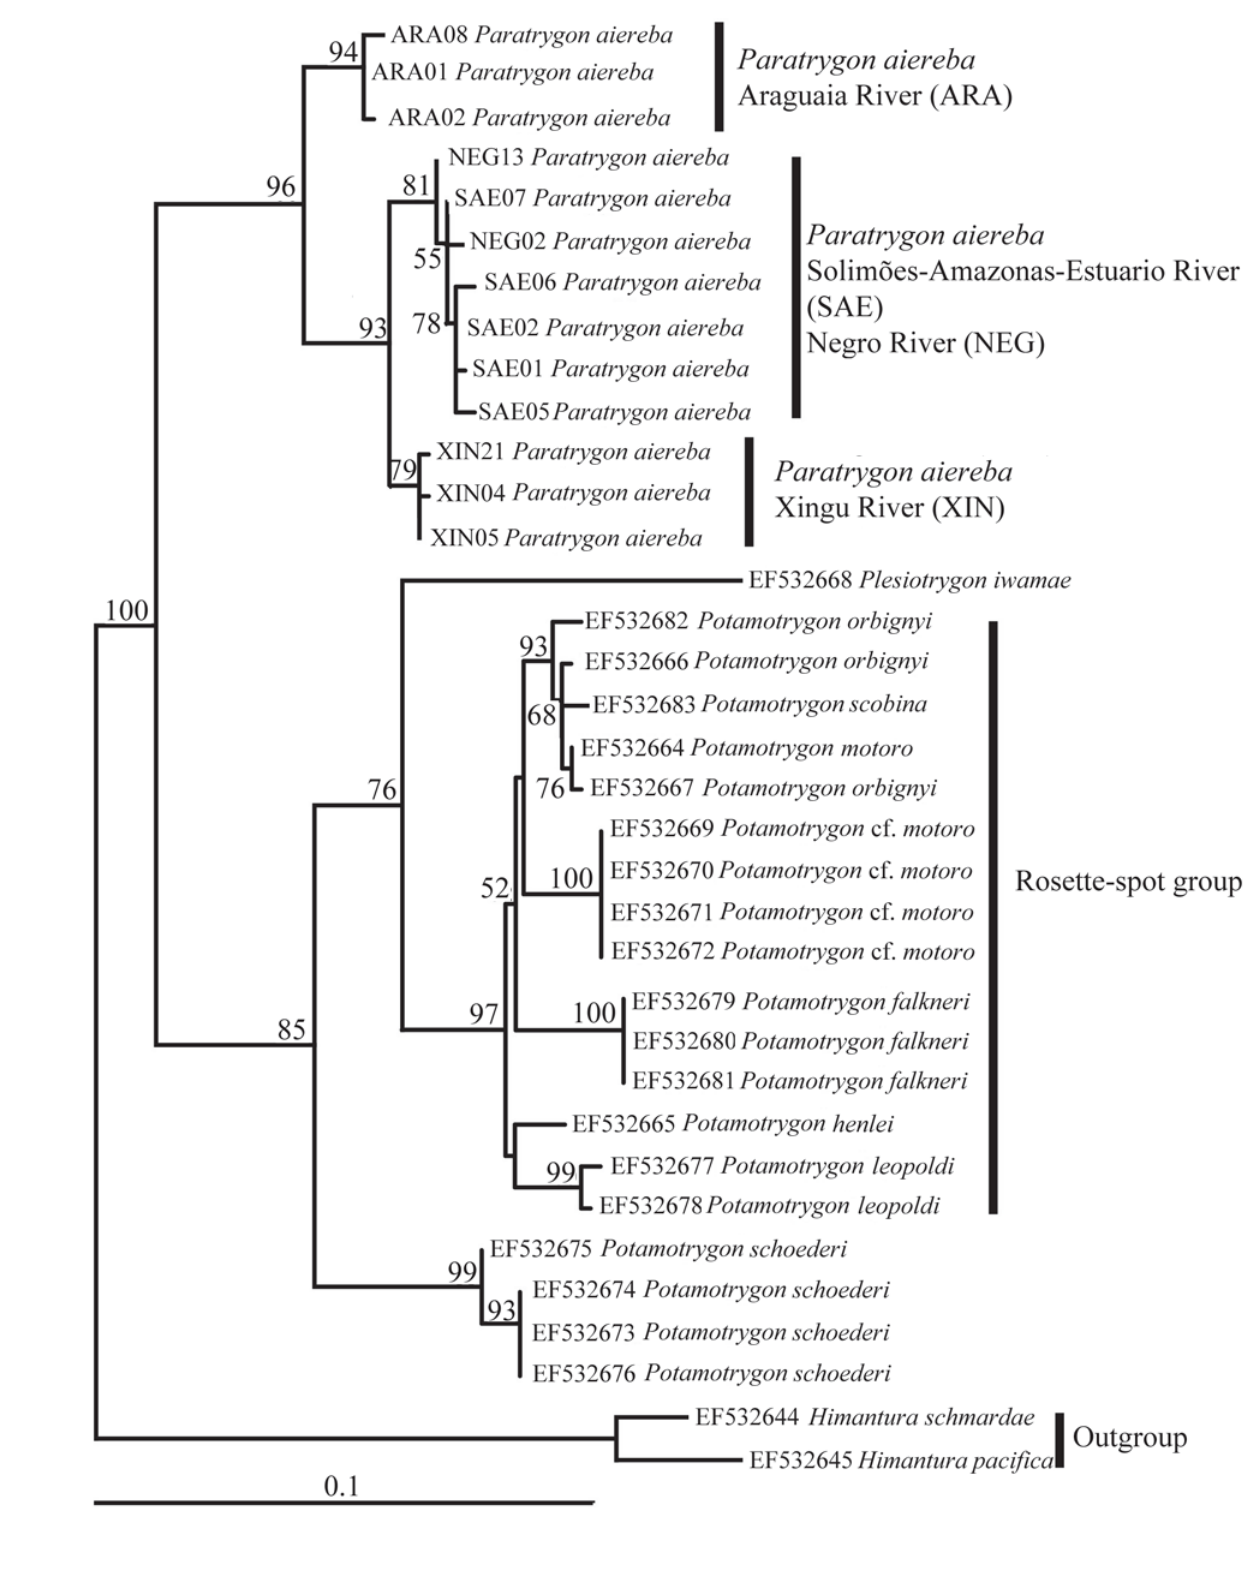
Fig 2. Neighbor Joining (NJ) tree for partial COI gene of Paratrygon aiereba combined with data from Toffoli et al . (2008). Numbers above the line are bootstrap support